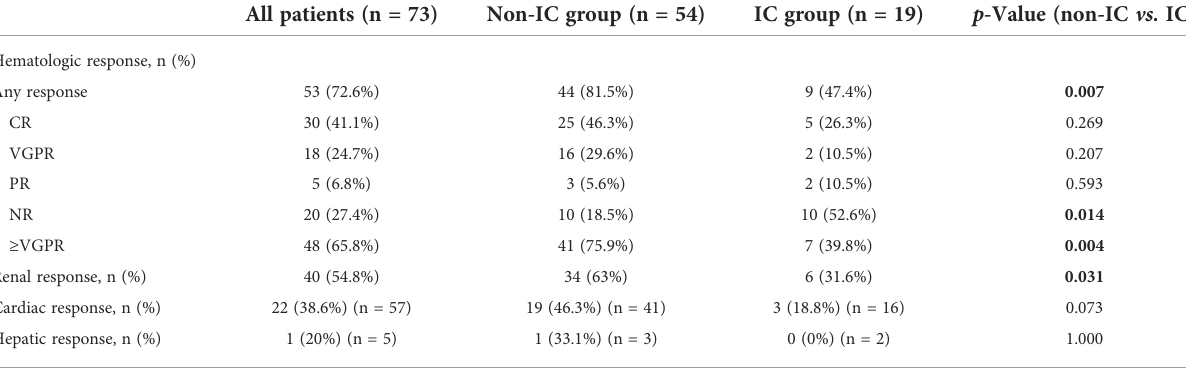
TABLE 3 Best hematological and organ response between the IC group and the non-IC group. All patients (n = 73) Non-IC group (n = 54) IC group (n = 19) p- Value (non-IC vs. IC)